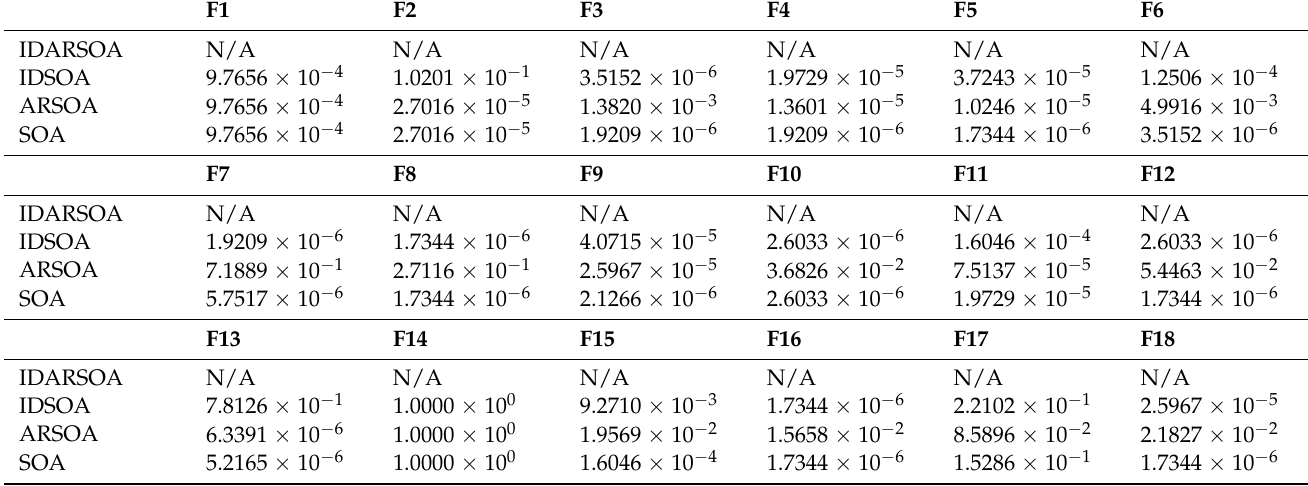
Table 5. Comparison of Wilcoxon signed-rank test results of different